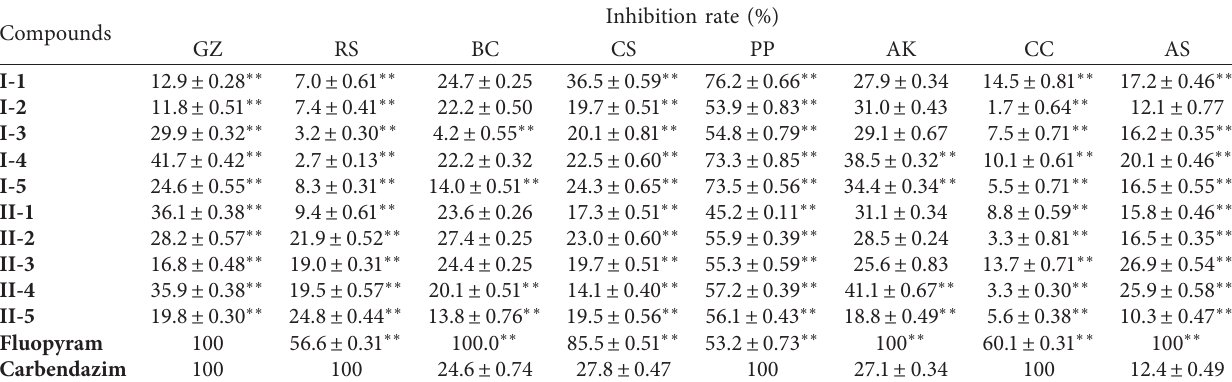
Table 3: In vitro inhibitory activity of the target compounds at 50 μ g · mL − 1 . Compounds